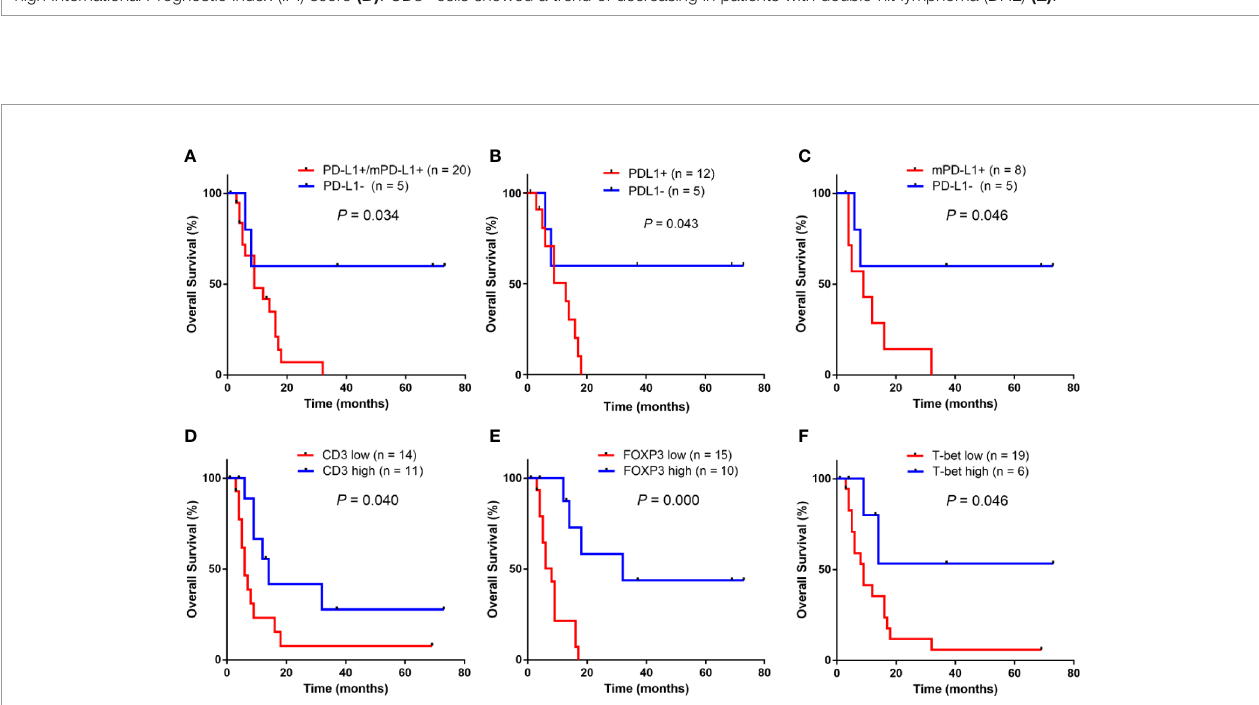
FIGURE 4 | Univariate survival analysis for anaplastic variant of diffuse large B-cell lymphoma In ADLBCL, patients with PD-L1 + and/or mPD-L1 + (A – C) had a signi fi cantly poorer overall survival (OS) than those with PD-L1 - .An increase in CD3 + cell numbers, FOXP3 + cells numbers and T-bet + cell numbers were signi fi cantly associated with prolonged OS in patients with A-DLBCL was signi fi cantly worse than those who tested negative ( P < 0.05) (C – F)